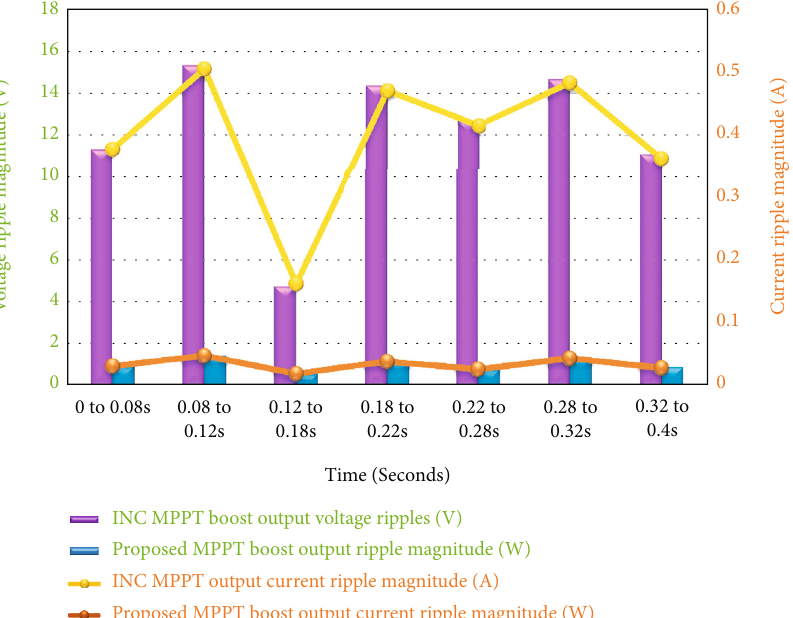
Figure 16: Output current and voltage ripple magnitude of the boost converter using INC and the proposed MPPT schemes.